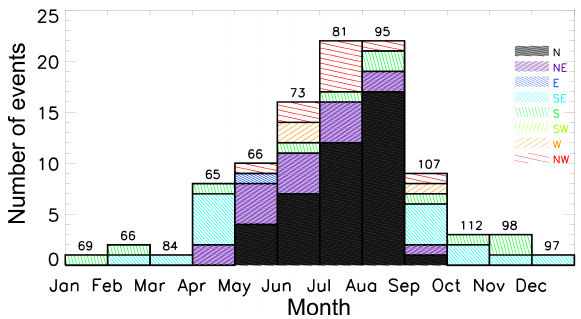
Figure 6. Annual distribution of the gravity waves. The number of the observed cloudless nights are shown at the top of the bars.